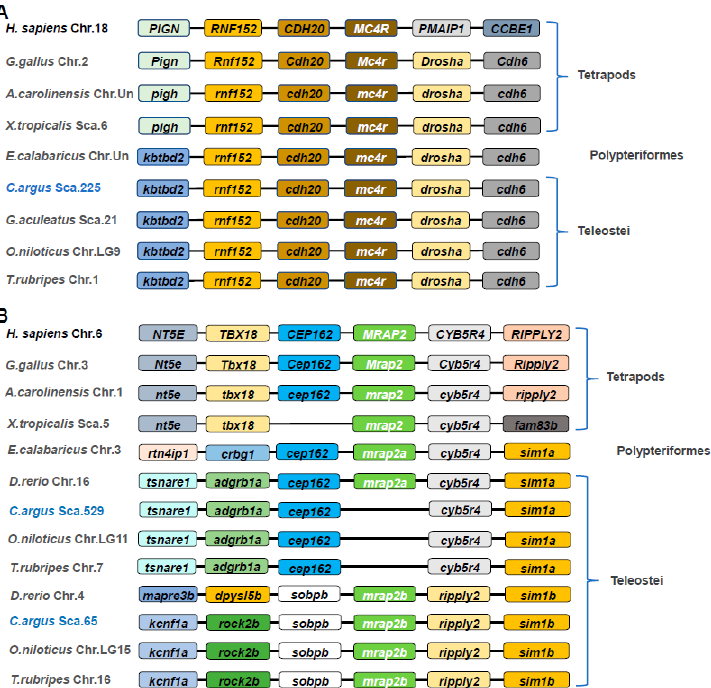
Figure 2. Comparative gene synteny of MC4R ( A ) and MRAP2 ( B ) among representative vertebrate genomes. The colored boxes represent genes and solid lines stand for intergenic regions. The genes showing conserved synteny were indicated with same color. Taxon names of selected species were shown on the left side of the